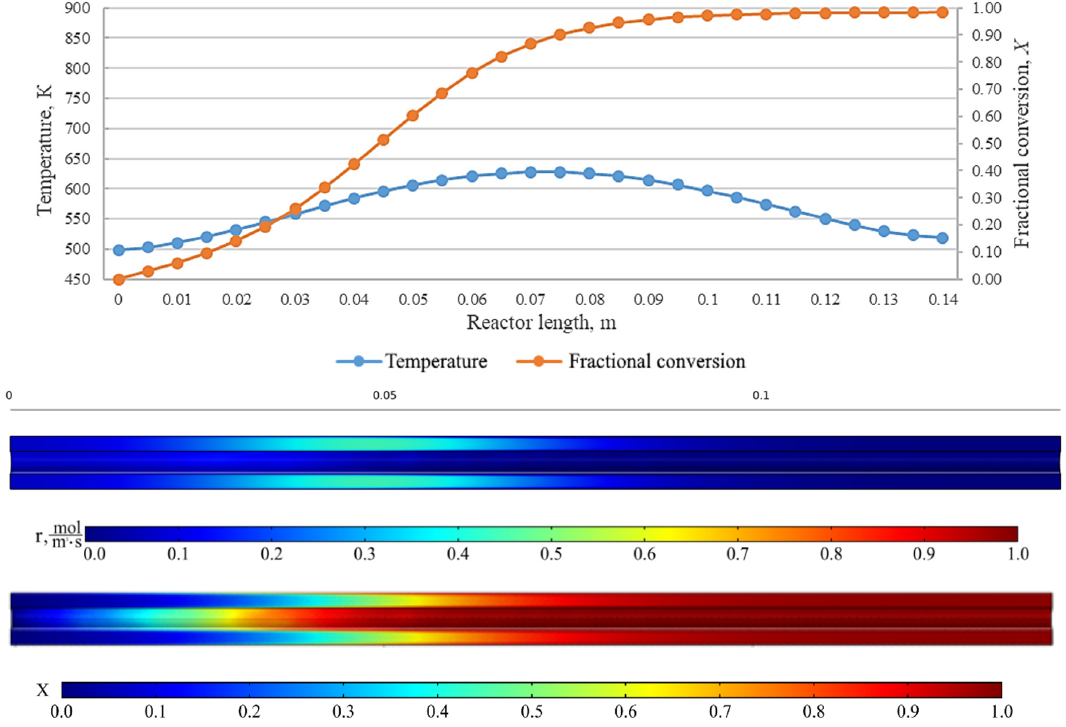
Figure 8. From top to bottom: temperature and fractional conversion curves, profiles of the reaction rate and fractional conversion along the reactor length for the experiment BnOm_350_18 (Tmax = 350 °С , 𝑉(cid:4662) = 0.05 L/min).